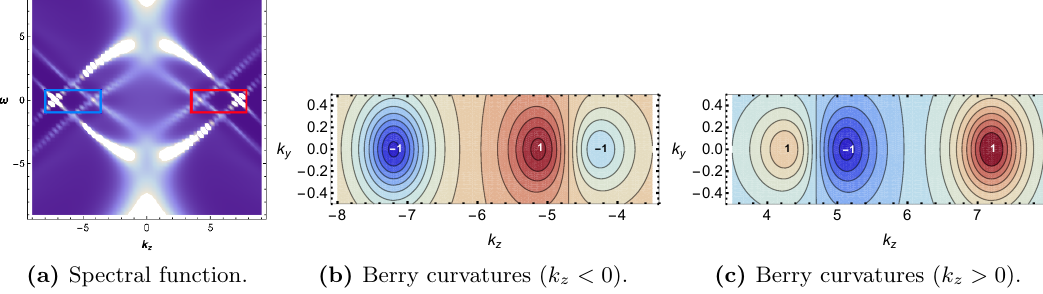
Figure 11. (a) Spectral function with k x = 0 ; k y = 0. Colored boxes are the regions where we draw Berry curvatures at Fermi level in (b) and (c) with ( b; M ) = (8 ; 5 : 5) and T = 2 =(cid:25) . Each numbers in (b) and (c) represents winding number computed from Berry curvatures. As we can see from (cid:12)gure 10, this dipole structure can disappear when temperature goes